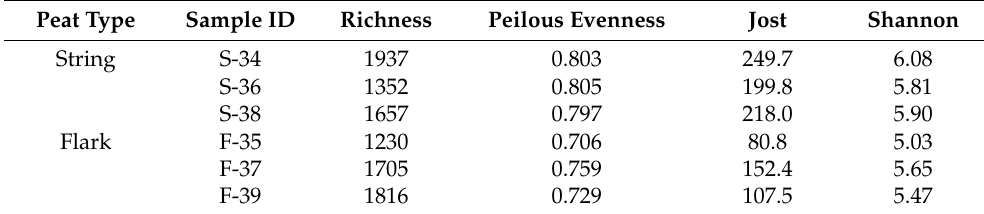
Table 2. Alpha-diversity metrics.